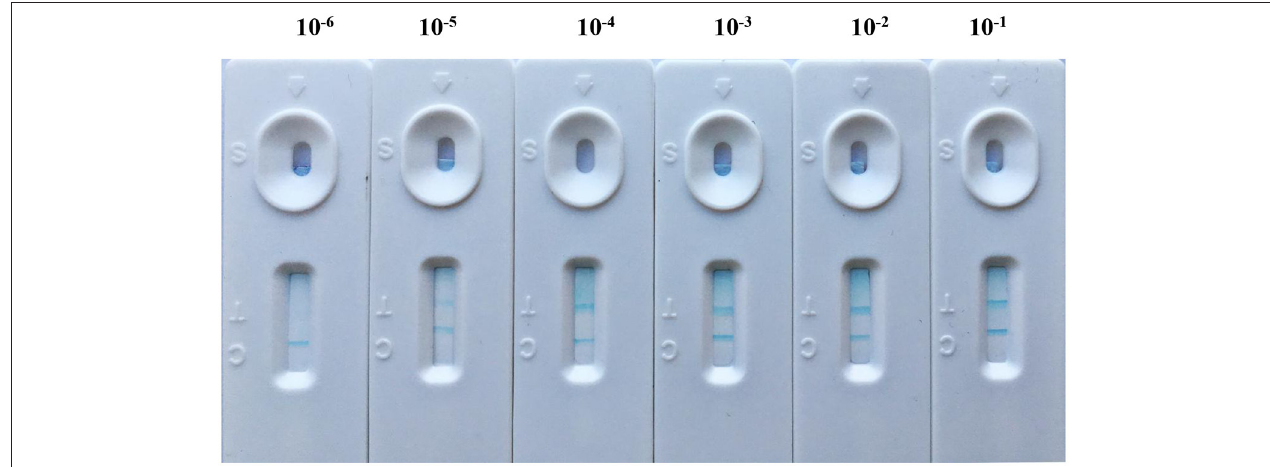
FIGURE 3 | The sensitivity of LFIA based on blue SiNPs for visible detection of standard brucellosis serum, after a series of standard brucellosis-positive serum (standard brucellosis-positive serum was diluted to 10 − 1 to 10 − 6 IU/ml) were mixed with blue SiNPs. and made it difficult for the blue SiNPs to be coated on the